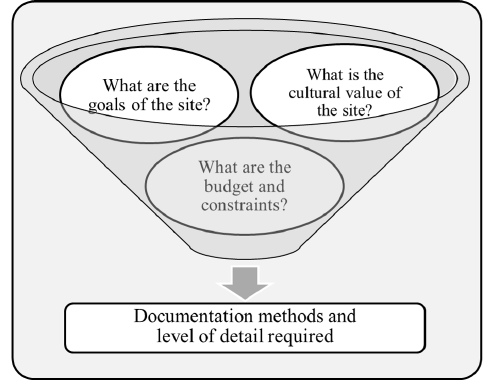
Figure 1. Current state of Cuba’s National Ballet School with main dome depicted in the background